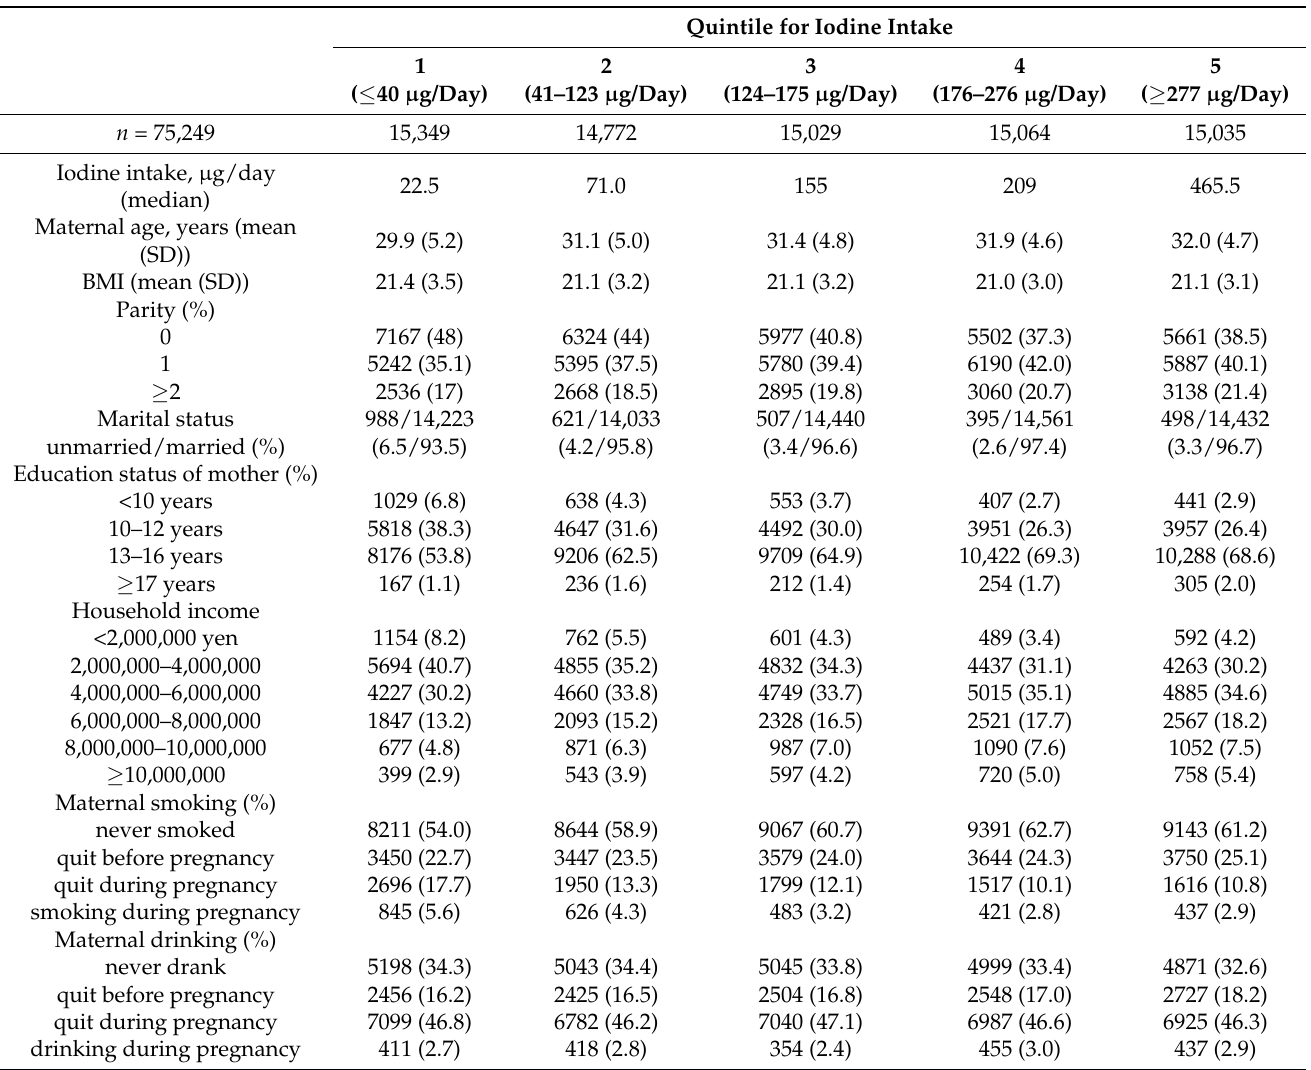
Table 1. Participant characteristics according to the quintiles for iodine intake during pregnancy. Quintile for Iodine